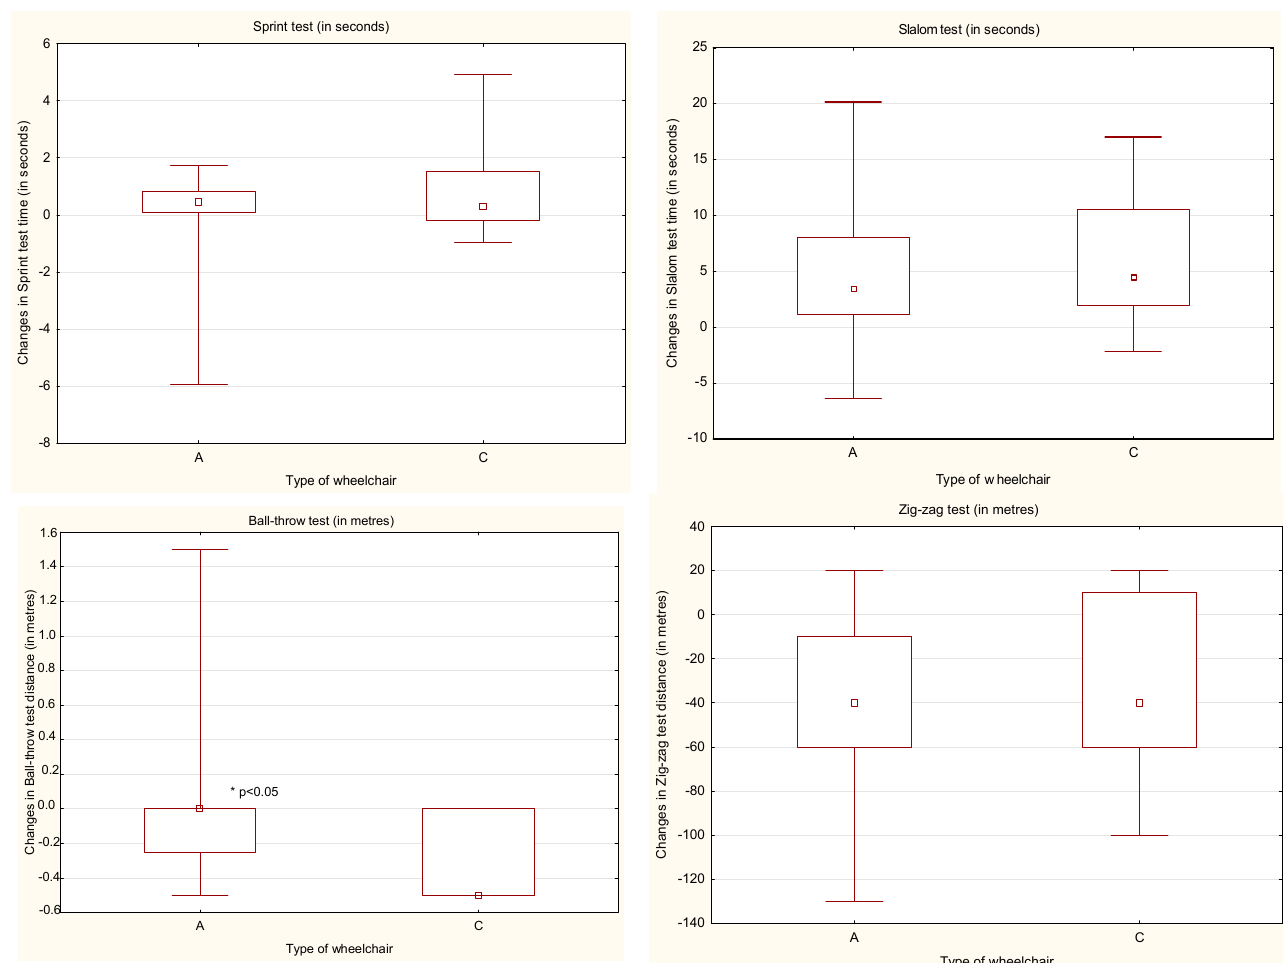
Figure 4. The changes in the results obtained before and after the ARC by the participants according to the type of wheelchair. A—active wheelchair; C—classic wheelchair.